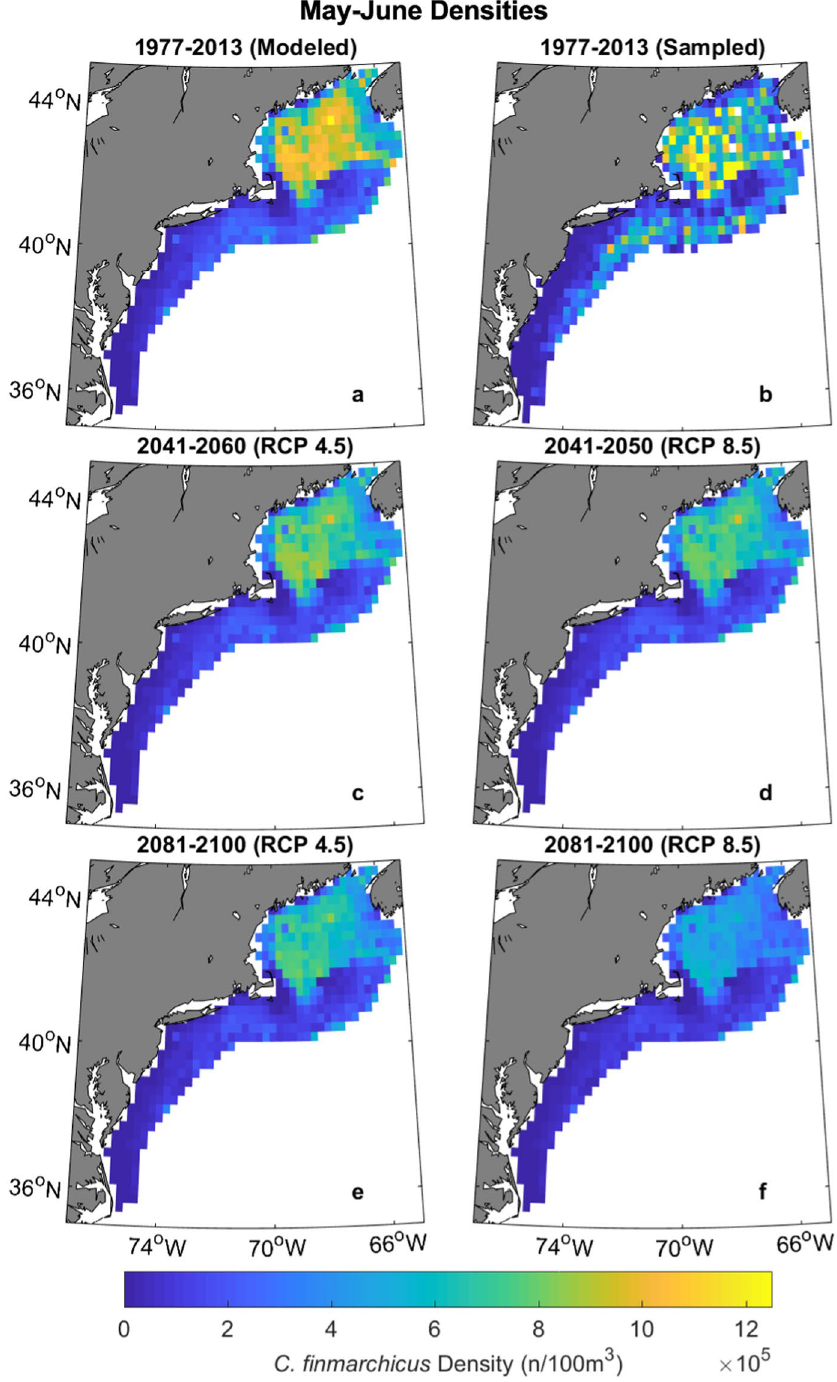
Figure 5. Projected May-June C . finmarchicus density over different time periods and climate scenarios. ( a ) Model hindcast under RCP 8.5. ( b ) Samples taken from 1977–2013. ( c ) Mean 2041–2060 density under RCP 4.5 and ( d ) RCP 8.5. ( e ) Mean 2081–2100 density under RCP 4.5 and ( f ) RCP 8.5. Figure was created by the first author in MATLAB v2015b (https://www.mathworks.com/products/matlab.html) using the package ‘M_Map’ v1.4 h